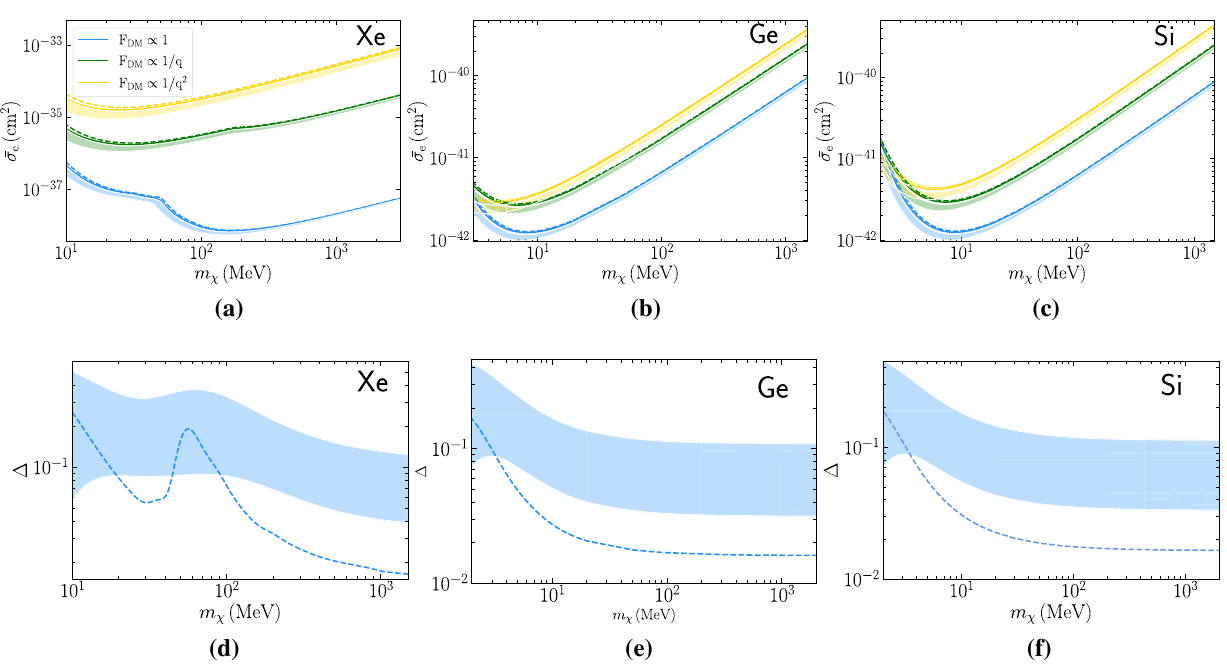
Fig. 1 Exclusion bounds in the SHM for fiducial and with recently obtained astrophysical parameters. In the upper panel, the solid lines are for the fiducial values and the dashed lines are the exclusion bounds foraModifiedMBdistribution(giveninEq.(9))withthefiducialvalues. The light blue, green and yellow shaded regions express the uncertain- ties in astrophysical observations for F DM = 1 , α m e / q and (α m e / q ) 2